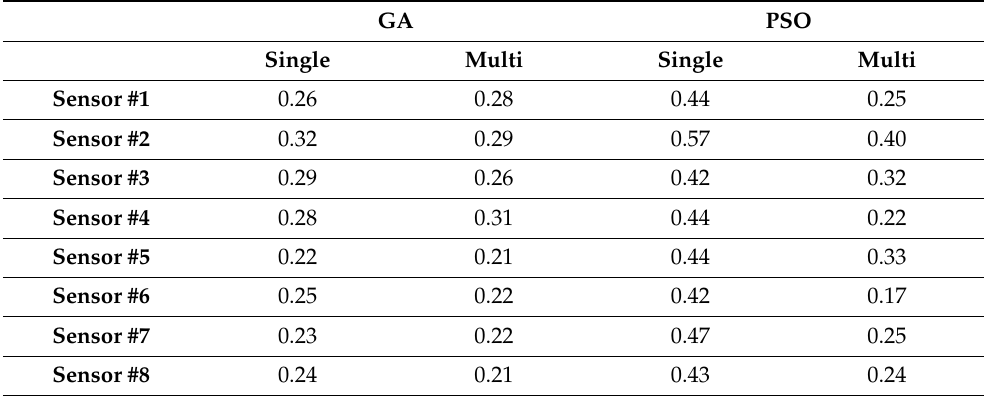
Figure 6. Deviation from exact location (in m) for each event (averaged over the eight sensors). Table 1. Deviation from exact location (in m) for each sensor (averaged over the six